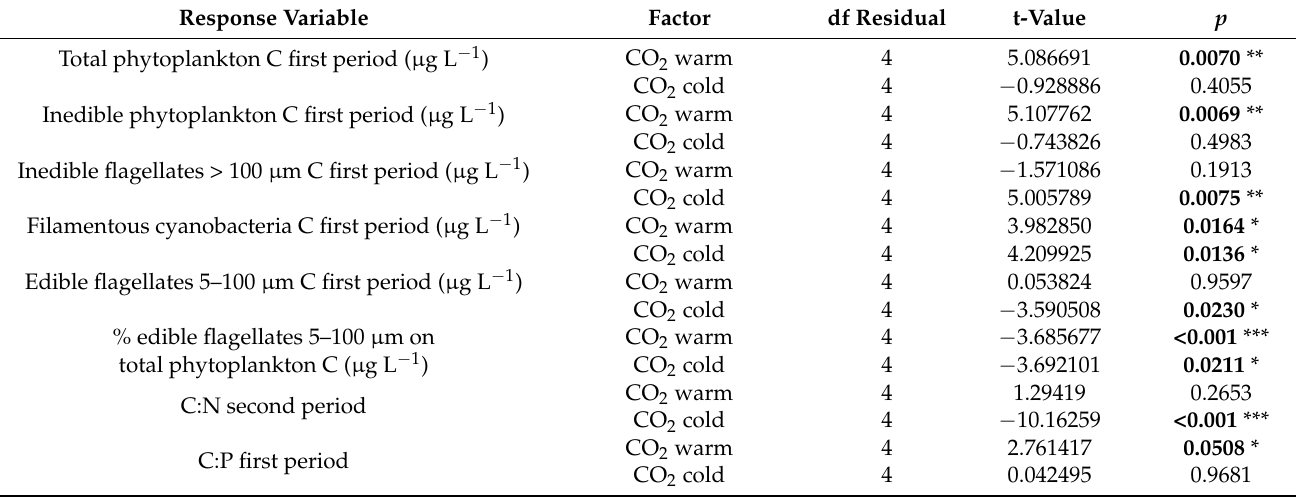
Table A2. Results of generalized least squares model (gls) testing for the effect of CO 2 under high and low temperature separately. Significant results are in bold. * p ≤ 0.05, ** p < 0.01, *** p <